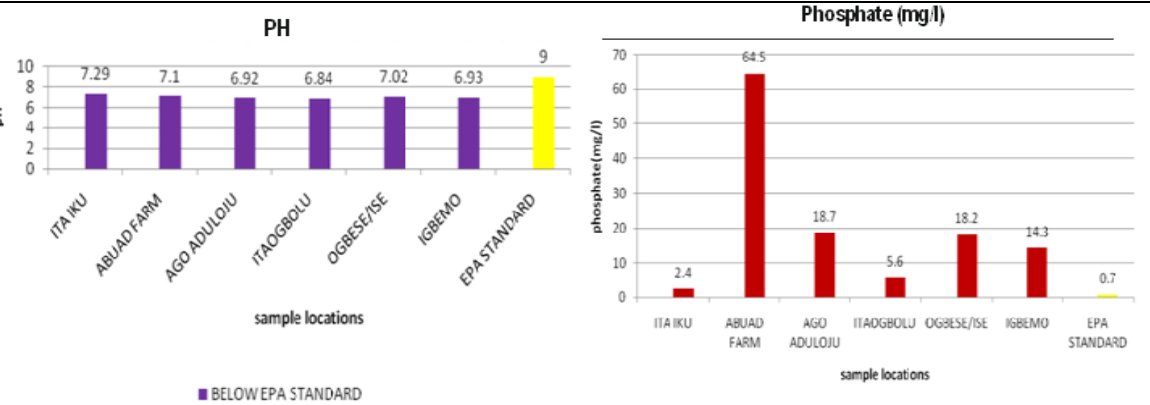
Figure 6: pH and Phosphate concentrations at various sites and in comparison with EPA standard.